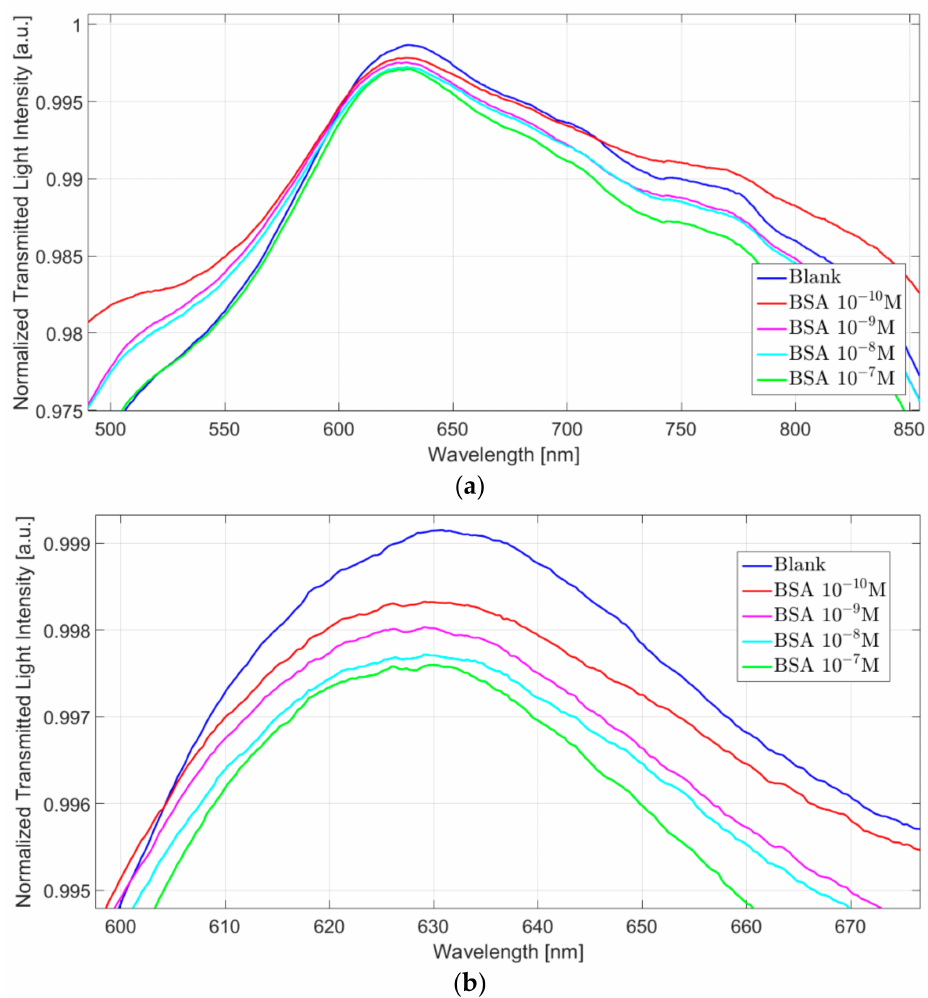
Figure 6. ( a ) Plasmonic spectra at varying of the BSA concentration (0–10 − 7 M) relative to “GNG- based orthogonal” configuration. ( b ) Zoom of the resonance wavelength